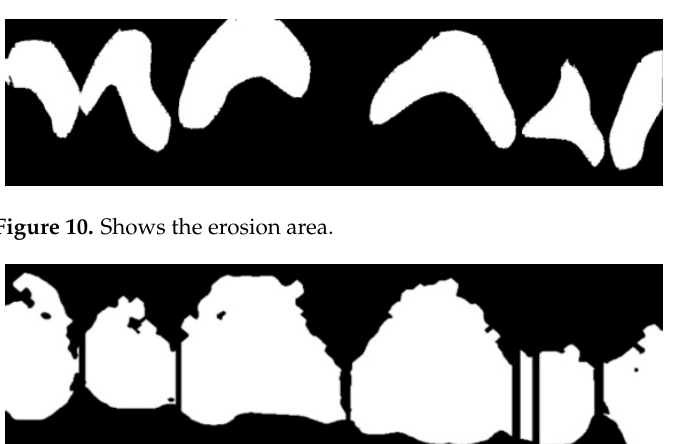
Figure 11. Shows the area of healthy tissue.